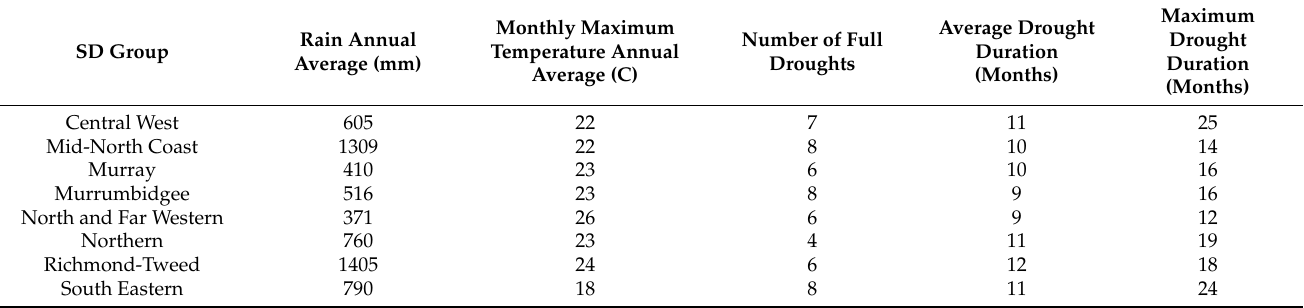
Table 1. Descriptive statistics of weather exposure data in rural NSW statistical divisions (SDs) during